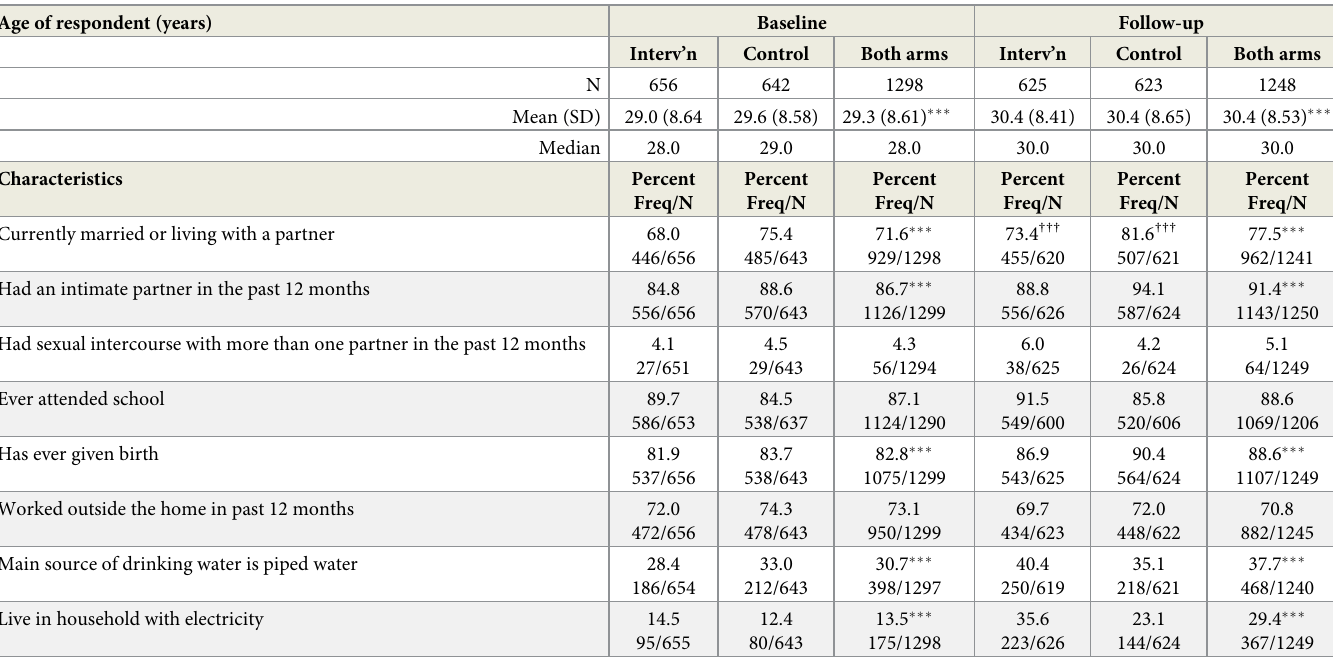
Table 3. Survey respondent characteristics.